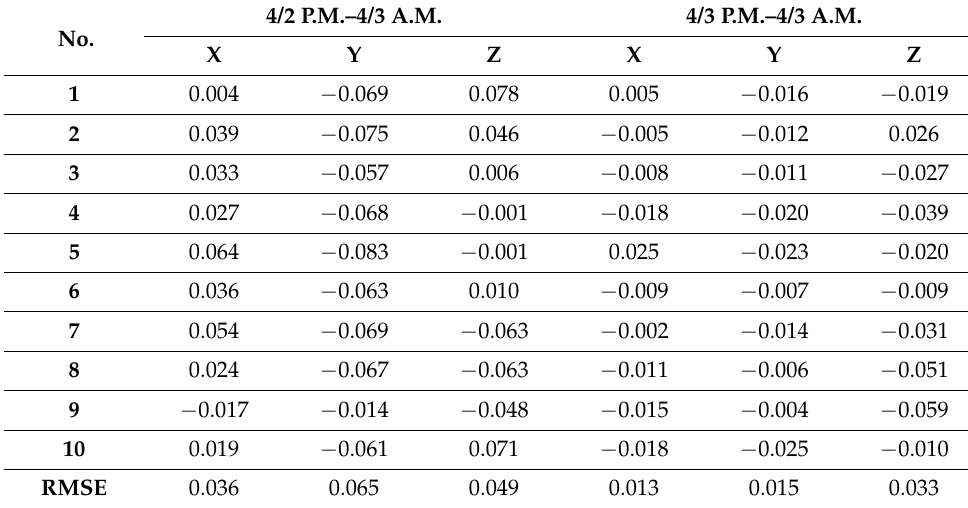
Table 2. Error and RMSE between the DSMs in the XYZ direction.